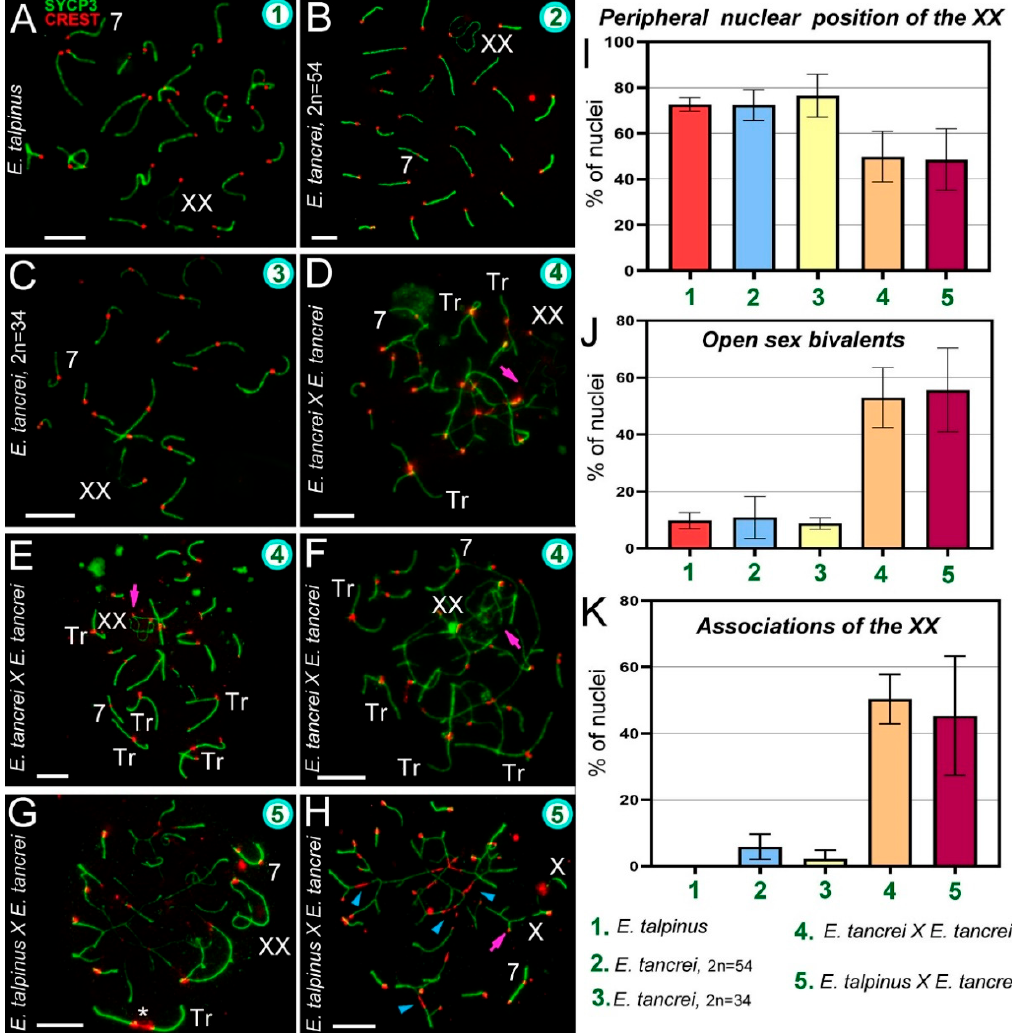
Figure 2. Chromosome synapsis and irregularities in pachytene spermatocytes of Ellobius species and hybrids. The green numbers in the micrographs and diagrams correspond to parental species and hybrids (see captions under diagram K). Pink arrows show associations of the sex (XX) bivalents ( D , E , F , H ). Chromosome #7 was clearly identified in all nuclei ( A – H ). ( A ) Ellobius talpinus : 26 synaptonemal complexes (SCs) and 1 XX bivalent. ( B ) E. tancrei (2 n = 54): 26 SCs and 1 XX bivalent. (C) E. tancrei (2 n = 34): 16 SCs and 1 XX bivalent. ( D – F ) Intraspecific hybrid E. tancrei × E. tancrei (2 n = 44): no nucleus had the expected chromosome formula (6 SCs, 1 XX bivalent, 10 SC trivalents). There were several SCs, 3–5 free SC trivalents, an XX bivalent, and SC trivalents in chains. ( G,H ) Interspecific hybrid E. talpinus × E. tancrei (2 n = 44): expected chromosome formula: 6 SCs, 1 XX bivalent, 10 SC trivalents. One nucleus contained 3 SCs, 1 XX bivalent, 1 SC trivalent with a stretched centromere